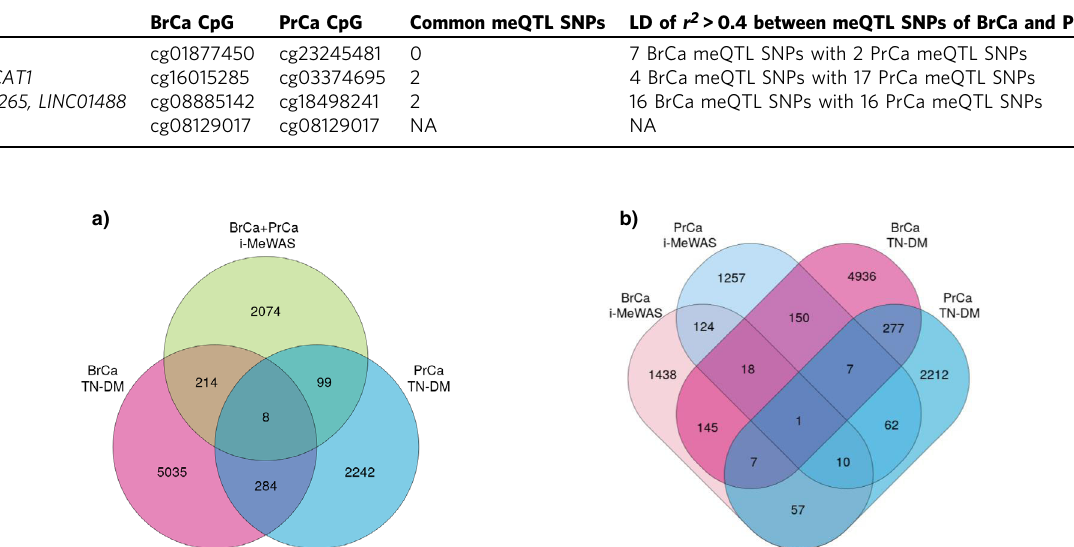
Table 6 Common differentially methylated CpGs in breast and prostate cancers identi fi ed using overlap analyses. CpG CHR Location (bp) Cytoband Gene